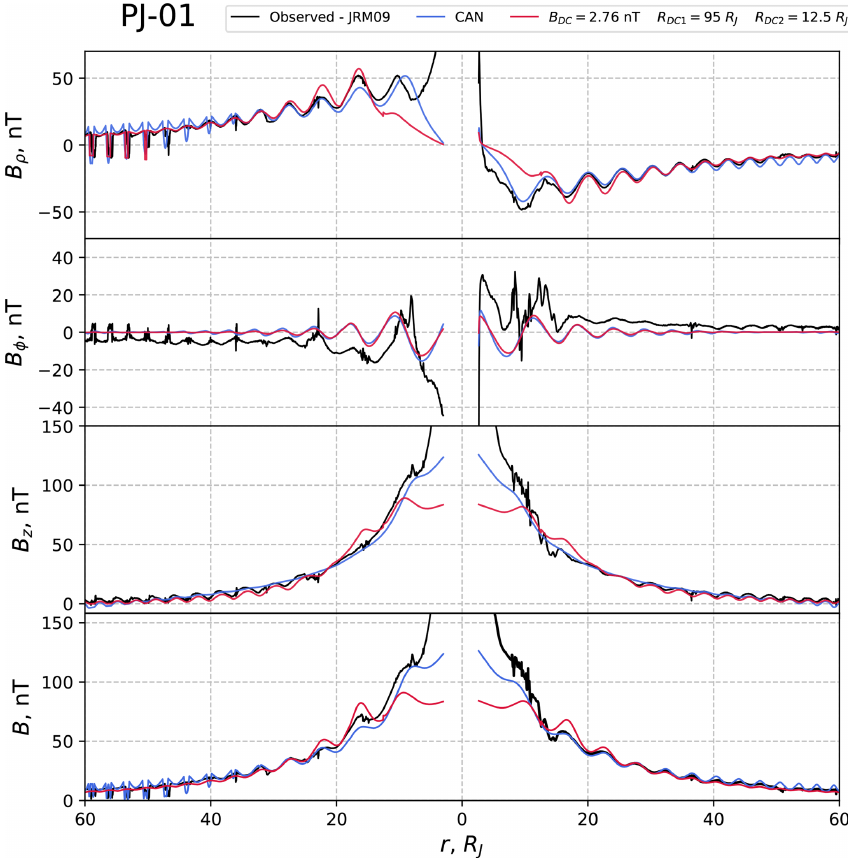
Figure 7. Comparison of the observed residual field (black) and best-fit Connerney et al. (1981) magnetodisc model field (blue) in a similar format to Fig. 5. We also show the best-fit paraboloid model (red) as in Fig.